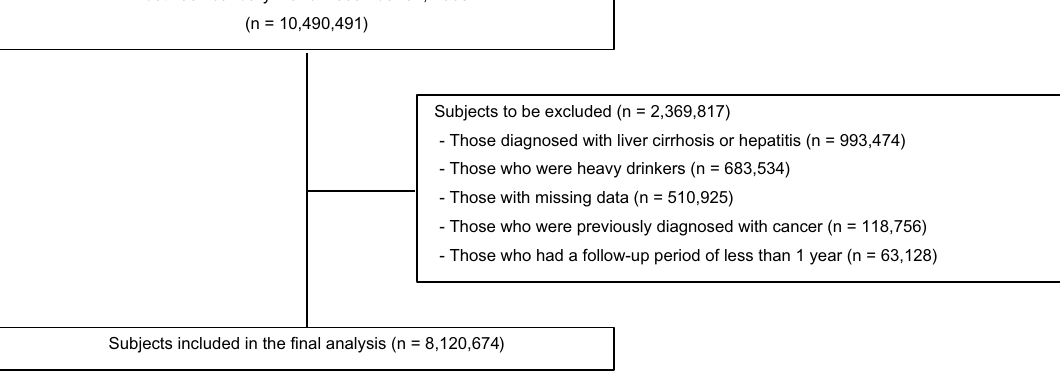
Figure 1. Flow diagram for the selection of the study